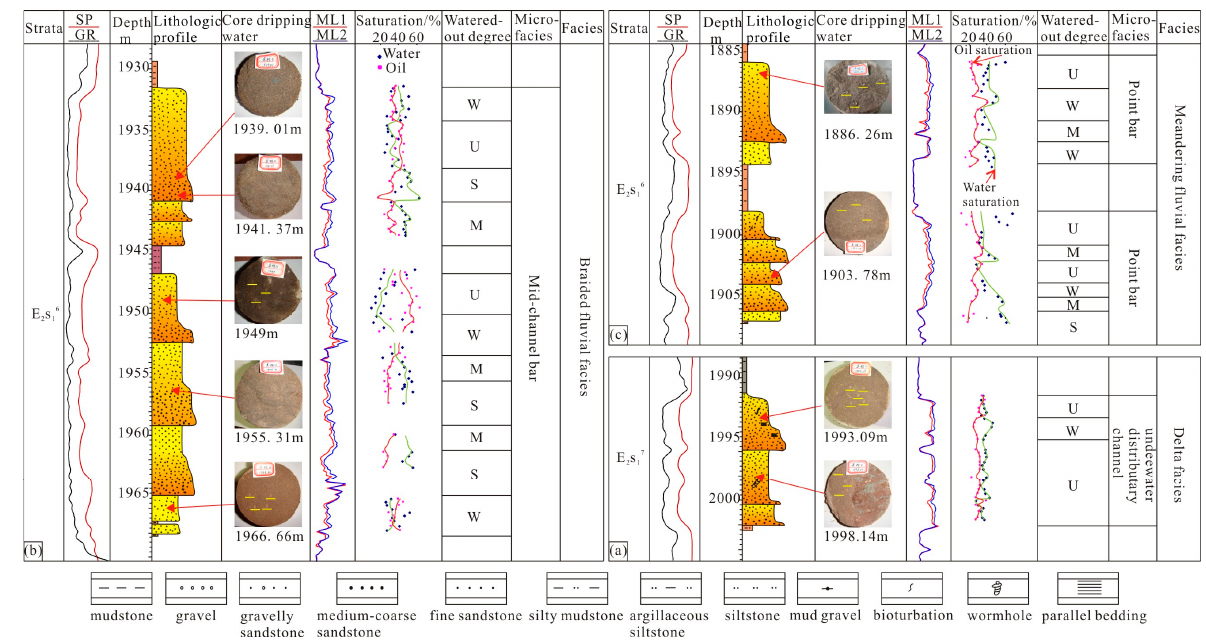
Figure 7. Influence of sedimentary type on water ‐ flooding degrees in the Zhenwu area, Gaoyou Sag. ( a ) Delta facies; ( b ) braided fluvial facies; ( c ) meandering fluvial facies. U: no water flooding; W: weak water flooding; M: medium water flooding; S: strong water flooding.